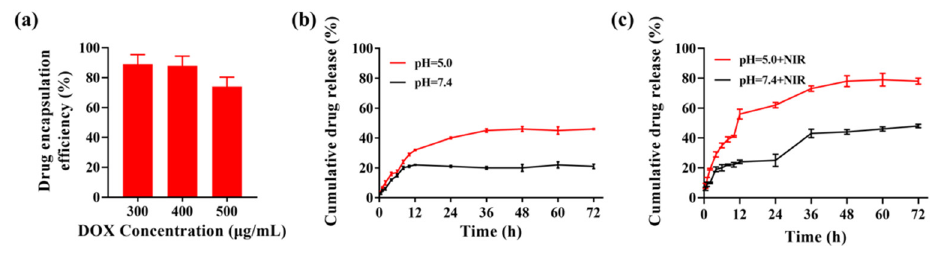
Figure 5. Drug loading capacity and release behavior of GQDs/DOX@CCM. ( a ) Encapsulation efficiency of DOX with initial concentrations of 300, 400, and 500 µ g/mL. ( b ) DOX release from GQDs/DOX@CCM at pH 5.0 and pH 7.4. ( c ) DOX release from GQDs/DOX@CCM after 5 min of NIR laser irradiation (808 nm, 1.44 W/cm 2 ).